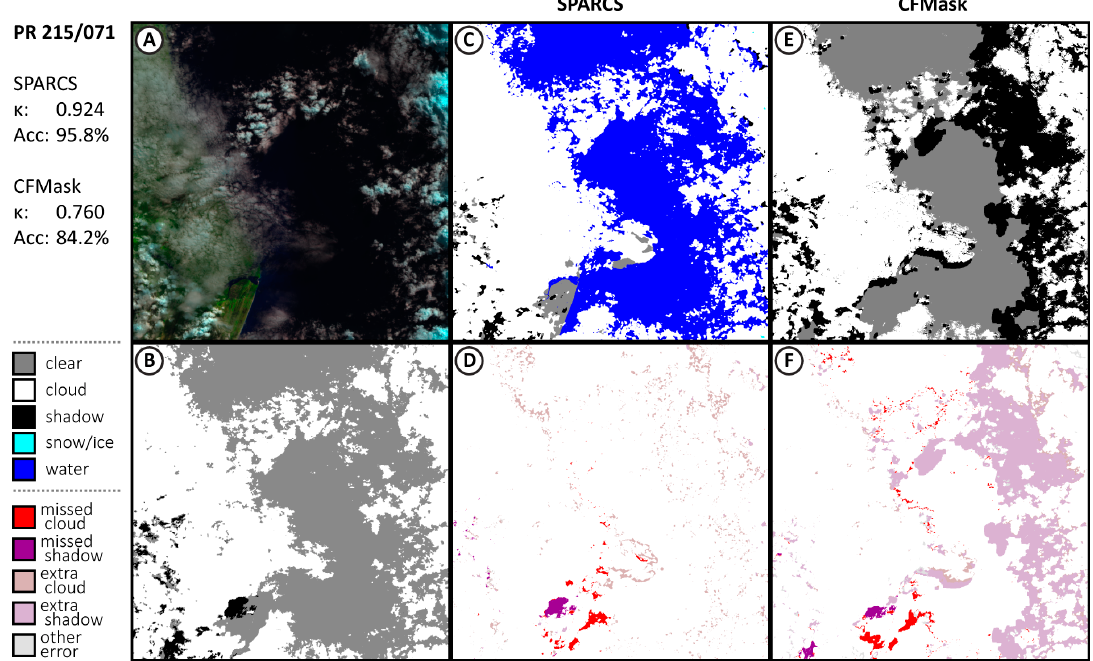
Figure A10. Results for Biome test image from PR 215/071, with false color image used during interpretation (A), the manually labeled interpretation (B), generated masks from SPARCS (C) and CFMask (E), and respective spatial distribution of errors (D, F).